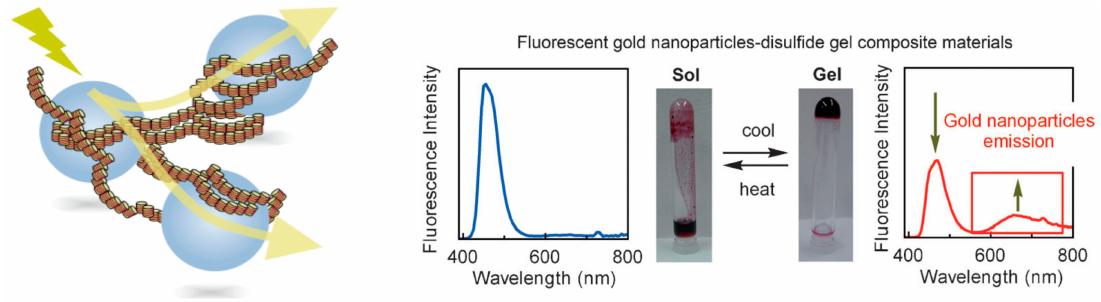
Figure 33. Light emission from composite materials derived from gold nanoparticles and hetero-double-helices self-assembly gels. Changes in visual and fluorescence spectra are shown accompanying the sol-gel transition in response to thermal stimuli. Reproduced from reference 104 by permission from John Wiley &